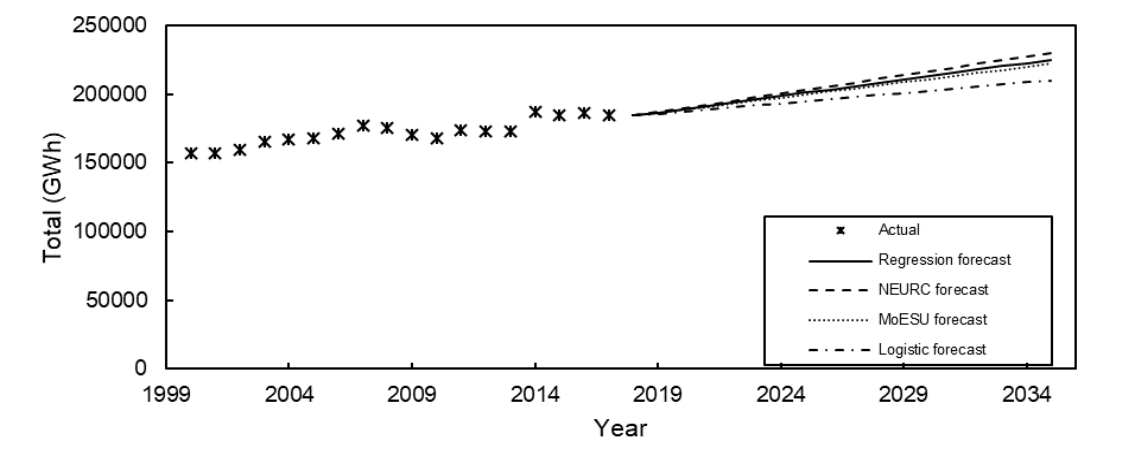
Figure 10: Comparison of forecasts for the total demand in